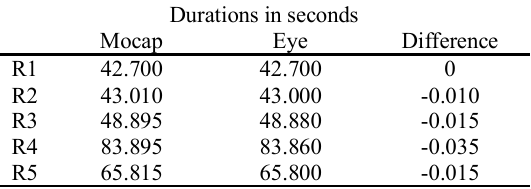
Table 4. Differences of recording durations in seconds of mocap and eye tracker for long recordings.